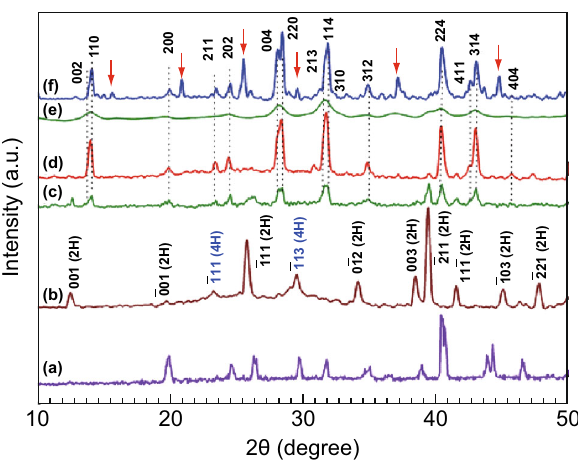
Fig. 14 XRD patterns of (a) CH 3 NH 3 I, (b) PbI 2 , (c) ball milling for 10 min, (d) ball milling for 45 min, (e) CH 3 NH 3 PbI 3 /Al 2 O 3 , and (f) CH 3 NH 3 PbI 3 by solution crystallization process. Reproduced with permission Ref. [135]. Copyright (cid:2) 2016 Springer Science